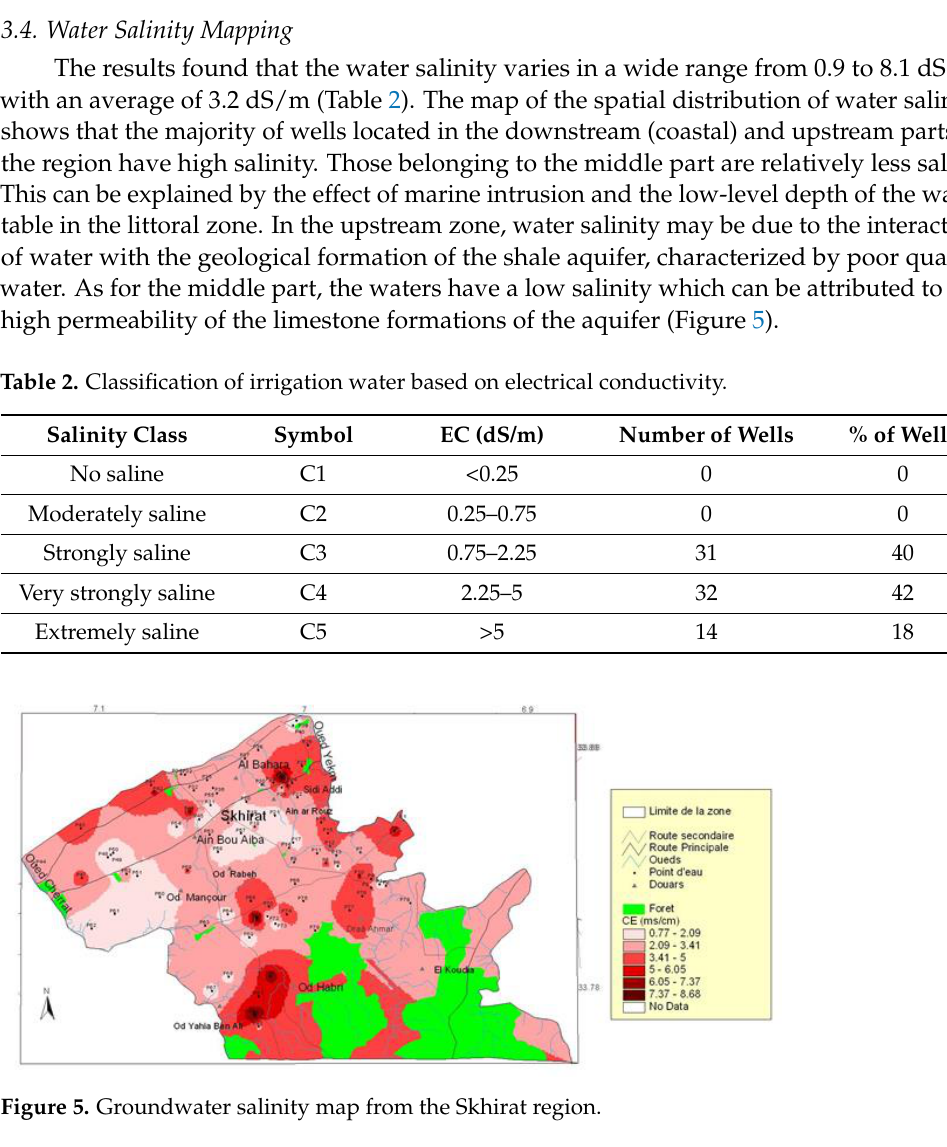
Figure 4. Classification of irrigation water (Richards, 1954).